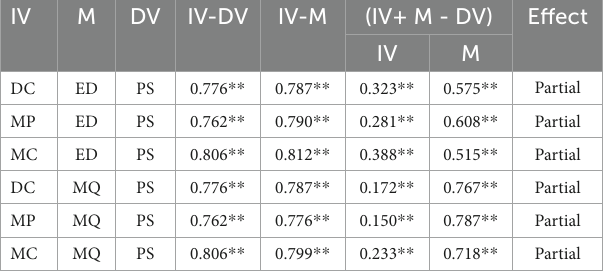
TABLE 9 Mediating effect of emotional dependence and patients’ perception of healthcare quality.